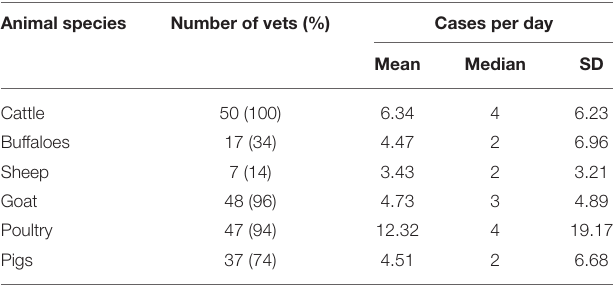
TABLE 2 | Animal species and number of cases per day investigated by veterinarians. Animal